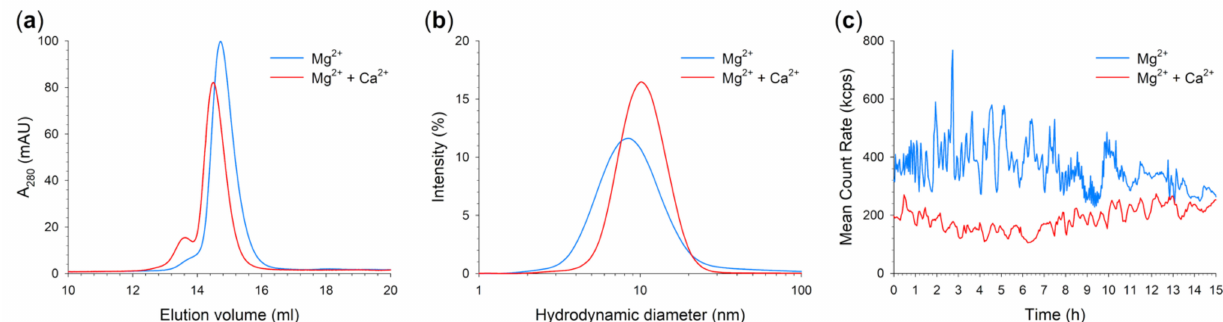
Figure 5. Quaternary structure and aggregation propensity of N104K-G105R monitored by analytical SEC and DLS. ( a ) Analytical SEC chromatograms of 42 µ M N104K-G105R in the presence of 500 µ M EGTA + 1 mM Mg 2+ (blue) or 500 µ M Ca 2+ + 1 mM Mg 2+ (red). ( b ) DLS measurements of 42 µ M N104K-G105R in the presence of 500 µ M EGTA + 1 mM Mg 2+ (blue) or 500 µ M Ca 2+ + 1 mM Mg 2+ (red). ( c ) Time evolution of the mean count rate over 15 h of 42 µ M N104K-G105R in the presence of 500 µ M EGTA + 1 mM Mg 2+ (blue) or 500 µ M Ca 2+ + 1 mM Mg 2+ (red). Analytical SEC and DLS experiments were carried out in 20 mM Tris-HCl pH 7.5, 150 mM KCl, 1 mM DTT buffer. Estimations of the apparent MM and the hydrodynamic diameter are reported in Table 2.